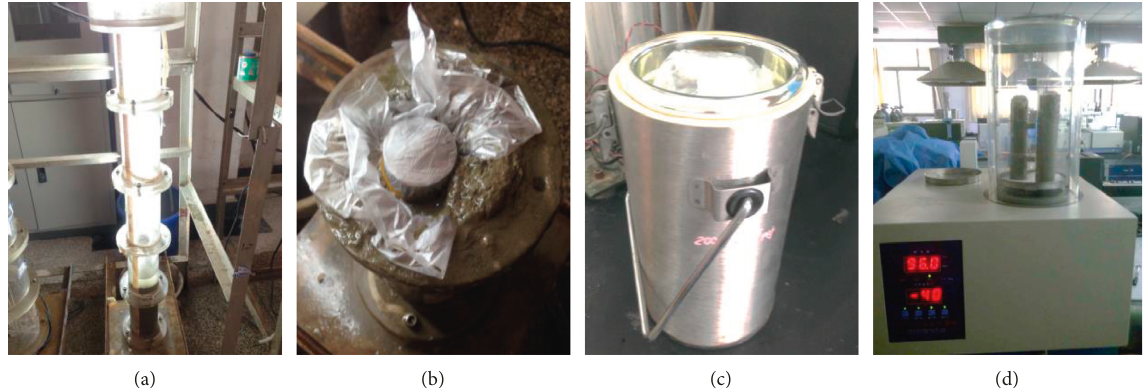
Figure 2: Mud bed sample preparation. (a) Thickening operation. (b) Sampling. (c) Deep-freezing. (d)